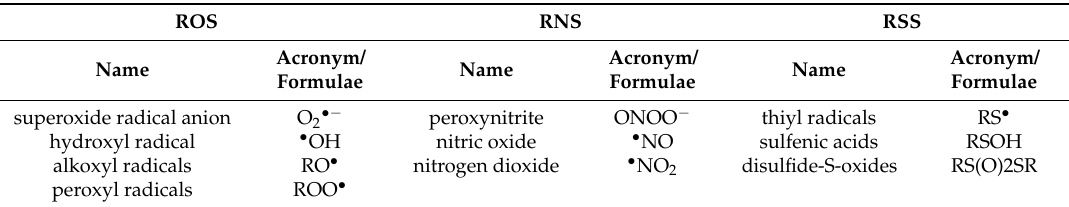
Table 1. Some of the most common oxidants in living